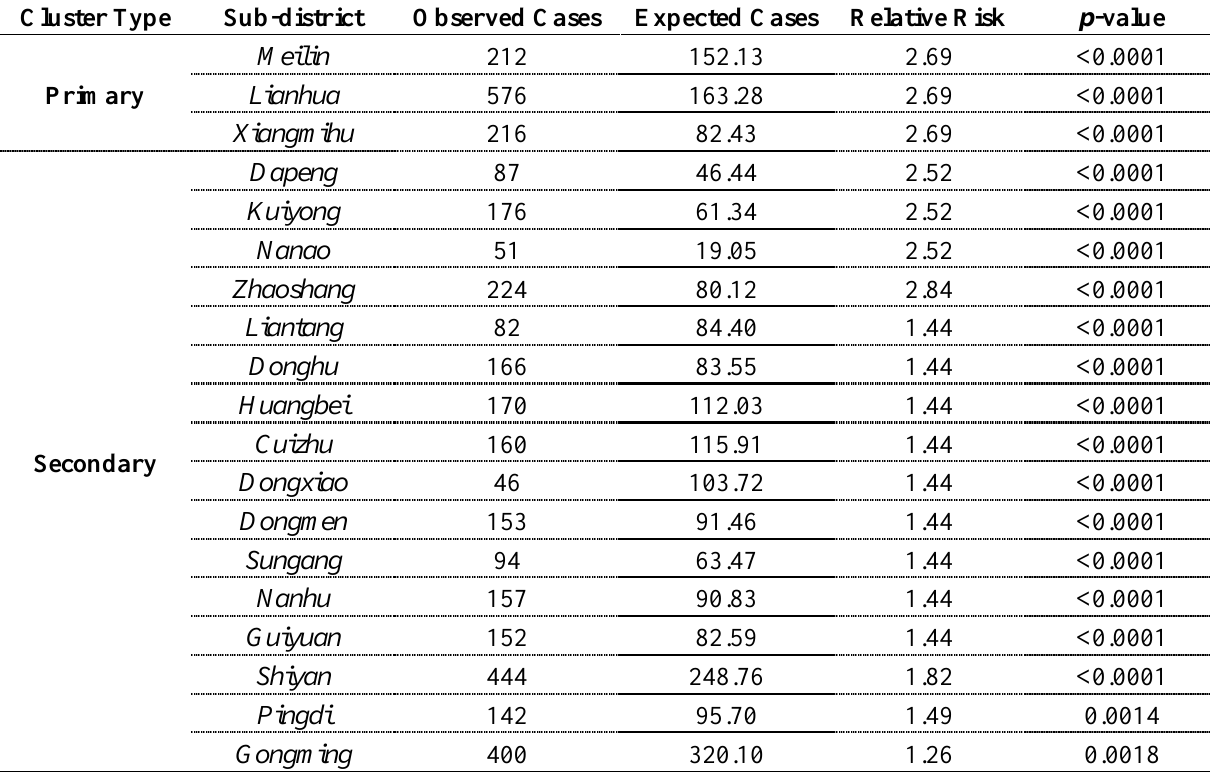
Table 2. The clusters of the relative risk in Shenzhen, 2011 from SaTScan using a purely spatial analysis.